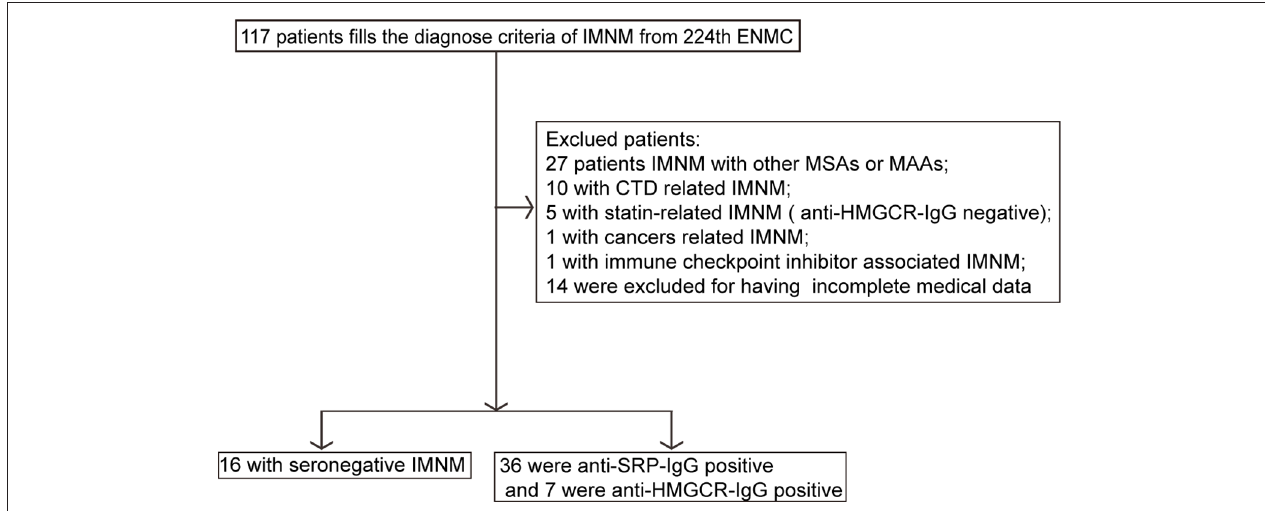
FIGURE 1 | Study flow diagram. CTD, connective tissue disease; ENMC, European Neuromuscular Centre; IMNM, immune-mediated necrotizing myopathy; HMGCR, anti-3-hydroxy-3-methylglutarylcoenzyme a reductase; MAAs, myositis-associated antibodies; MSAs, myositis-specific antibodies; SRP, signal recognition particle; IgG, immunoglobulin